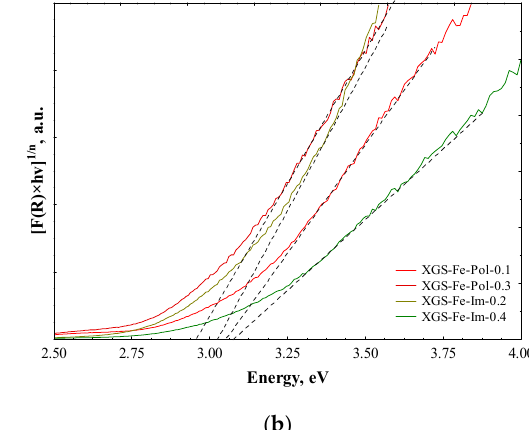
Figure 3. High-resolution XPS spectra for XGS and XGS-Fe-Im-0.2 ( a ) Si 2p; and ( b ) Fe 2p.